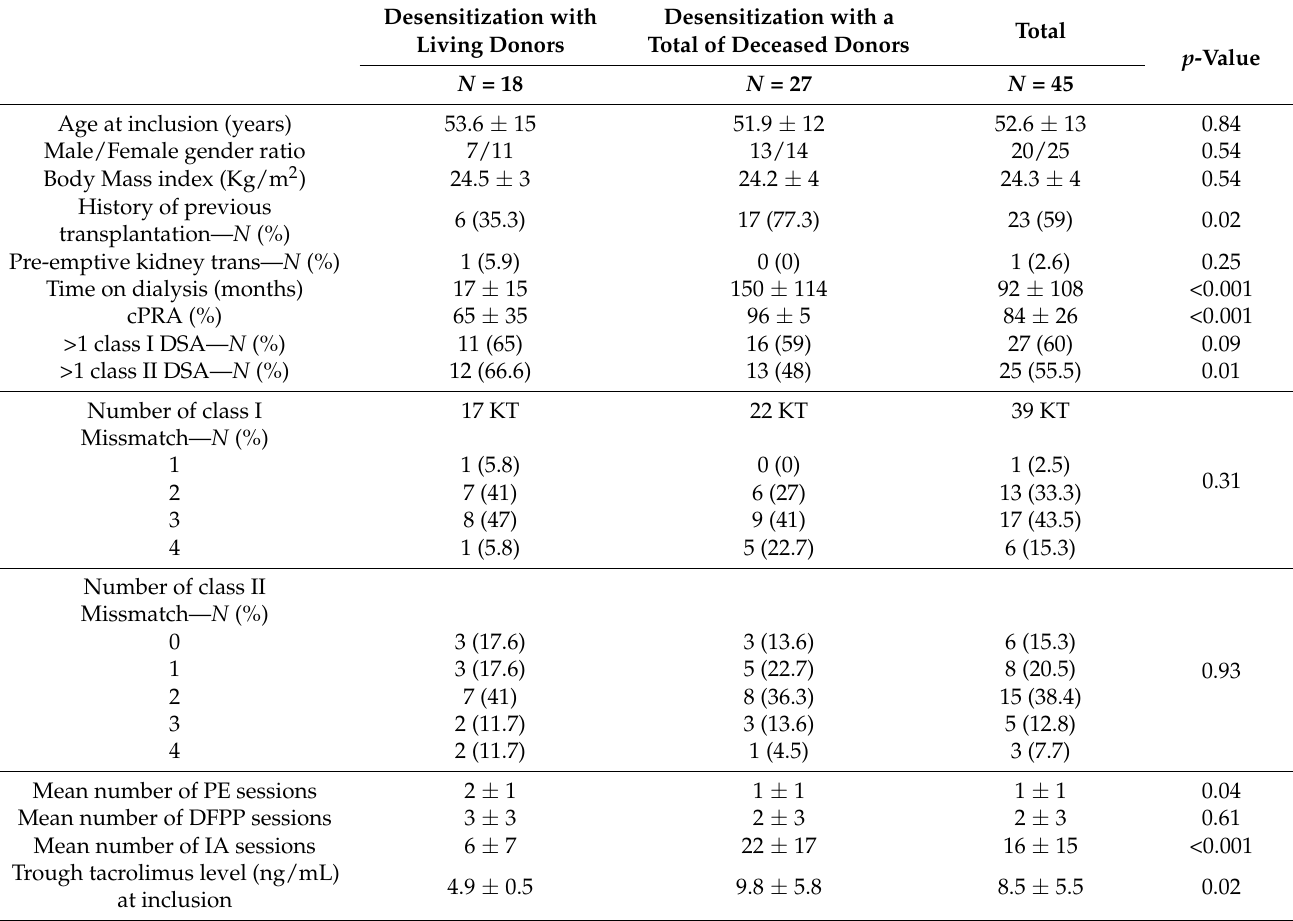
Table 1. Baseline characteristics of patients according to kidney transplant donor